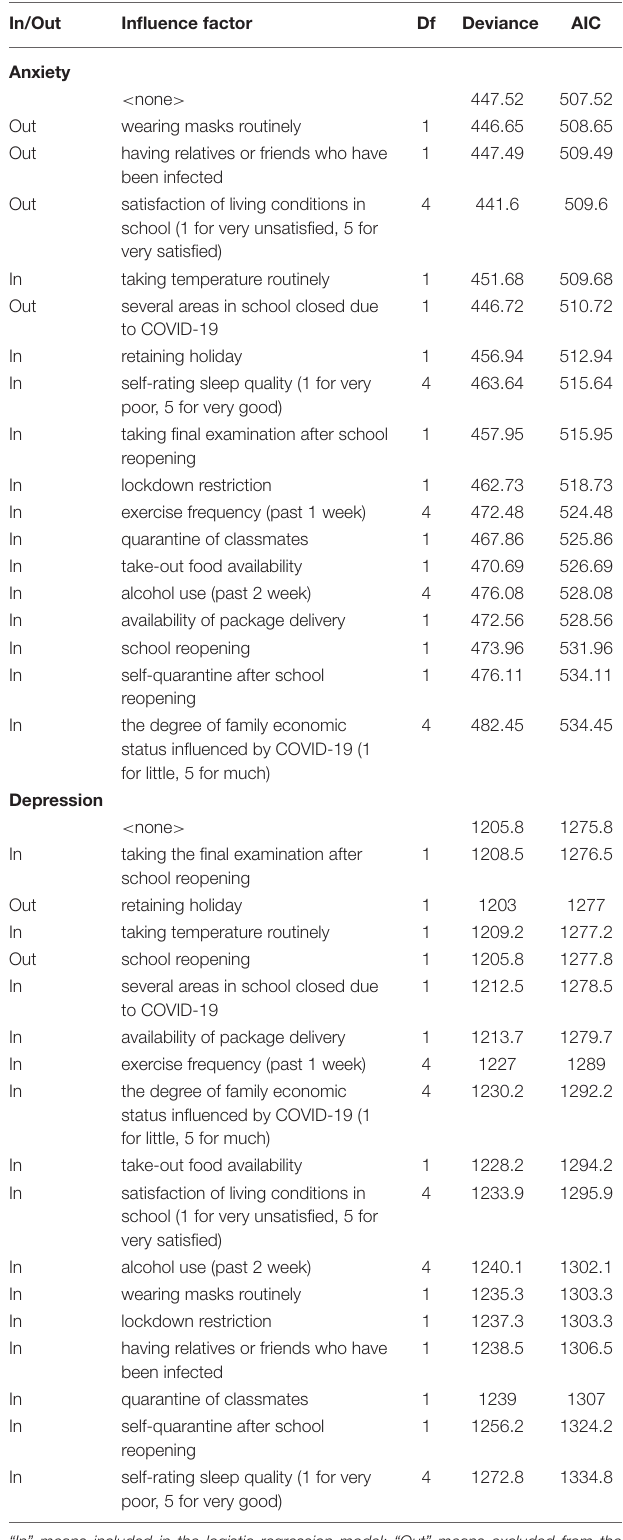
TABLE 3 | The Akaike Information Criterion (AIC) values of the 17 influence factors for anxiety and depression.